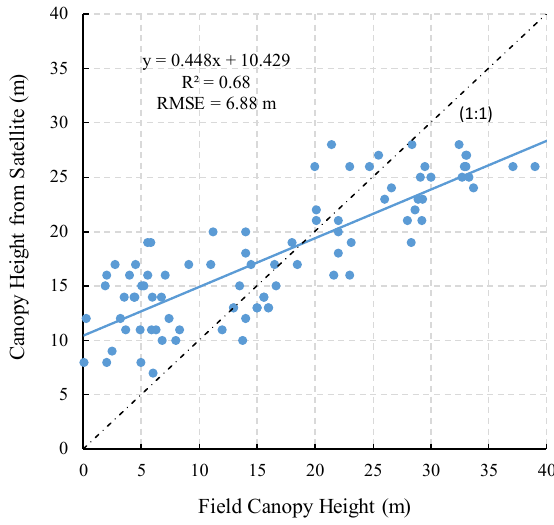
Figure 2. Comparison between field measurement and satellite product of canopy height.